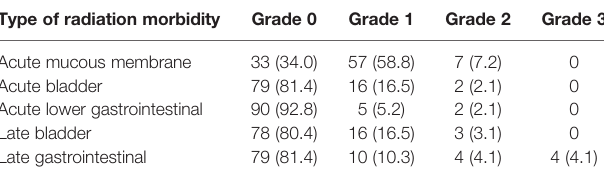
TABLE 6 | The distribution of different types of radiation morbidity ( n ,